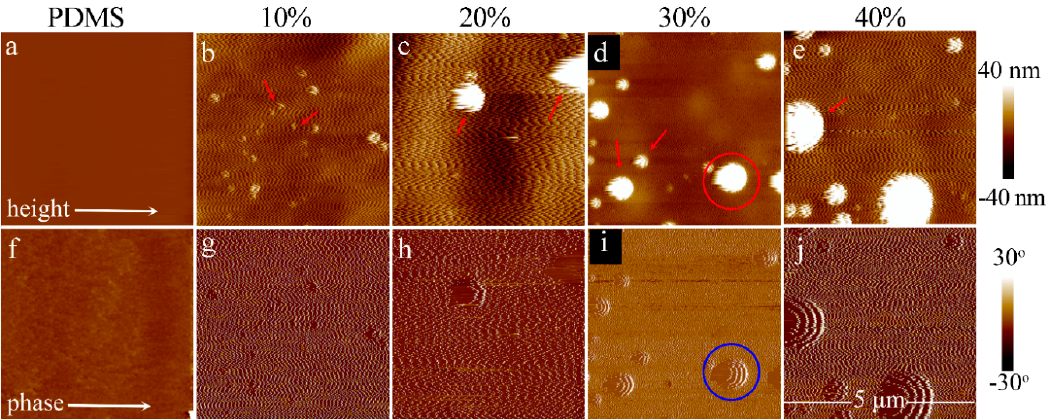
Figure 2. AFM ( a – e ) height and corresponding ( f – j ) phase images of pristine polydimethylsiloxane (PDMS), 10%, 20%, 30% and 40% coatings, respectively. The arrows and the circular parts indicate the white bulge of the coatings. The scale bar in ( j ) applies for the AFM images ( a – j ).